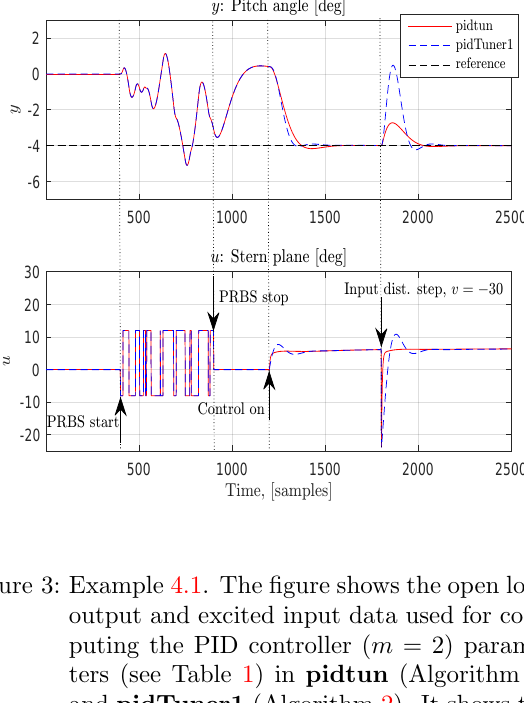
Figure 3: Example 4.1. The figure shows the open loop output and excited input data used for com- puting the PID controller ( m = 2) parame- ters (see Table 1) in pidtun (Algorithm 1) and pidTuner1 (Algorithm 2). It shows the reference, r = − 4, and input disturbance step, v = − 30, time domain responses of the closed loop system in Figure 2, comparing pidtun vs. pidTuner1 . The correspond- ing performance and input usage indices are found in Table